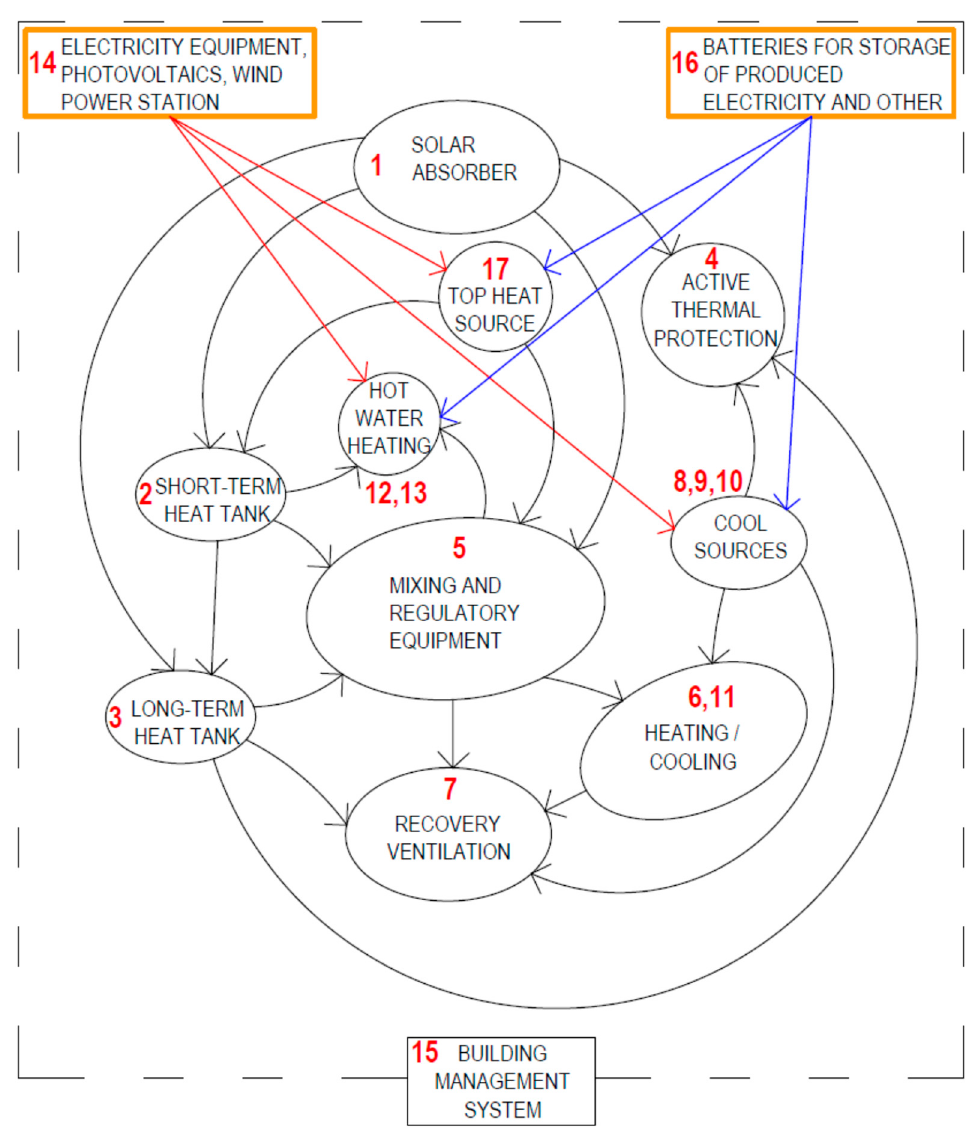
Figure 8. Diagram of the combined building and energy system’s functional wiring. 1—solar